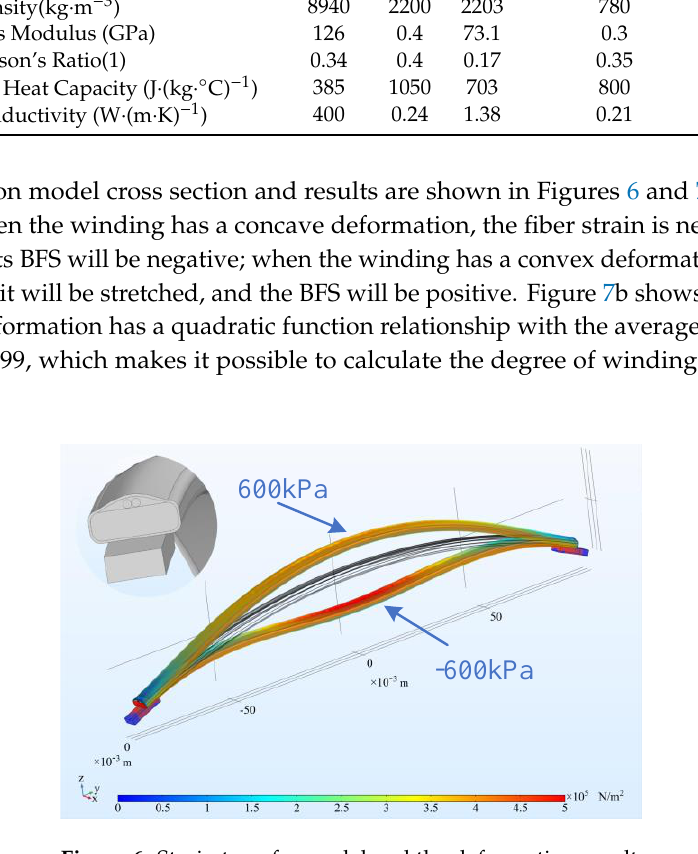
Table 1. Material Parameters for Simulation Model [13,26].